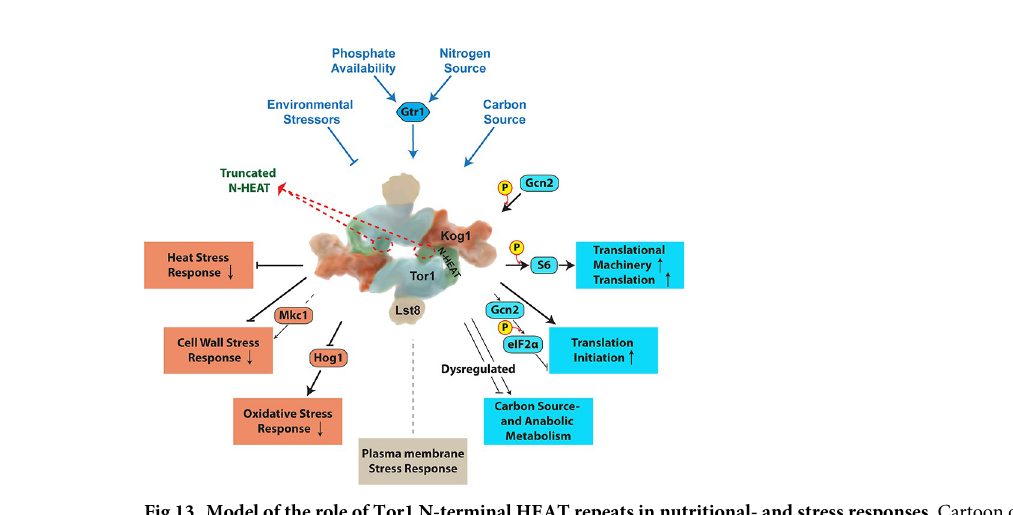
Fig 13. Model of the role of Tor1 N-terminal HEAT repeats in nutritional- and stress responses. Cartoon of TORC1 without Tco89 after PDB:6BCX and [14] with regulatory inputs and outputs examined in this work. Tor1 N- terminal HEAT repeats are shown in green and the remainder of the protein in